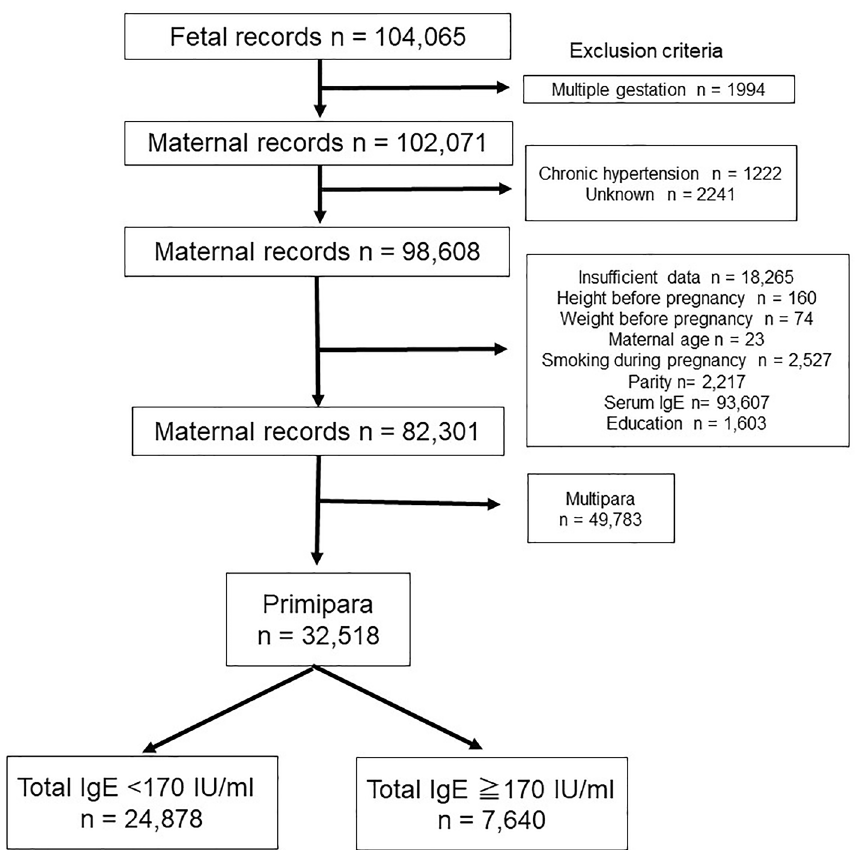
Figure 1. Flow chart of the study participants. IgE immunoglobulin